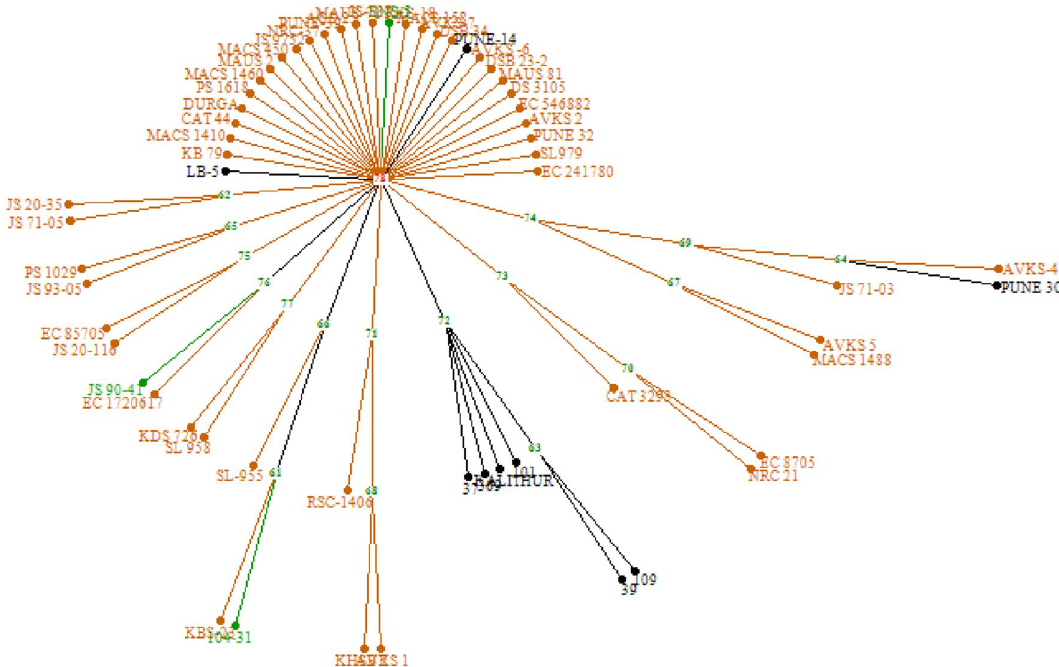
Figure 7. Hierarchical clustering of soybean genotypes based on UPGMA Euclidean distance (Black, Green, and Yellow colour lines indicate Black, Green, and Yellow seed coat colour